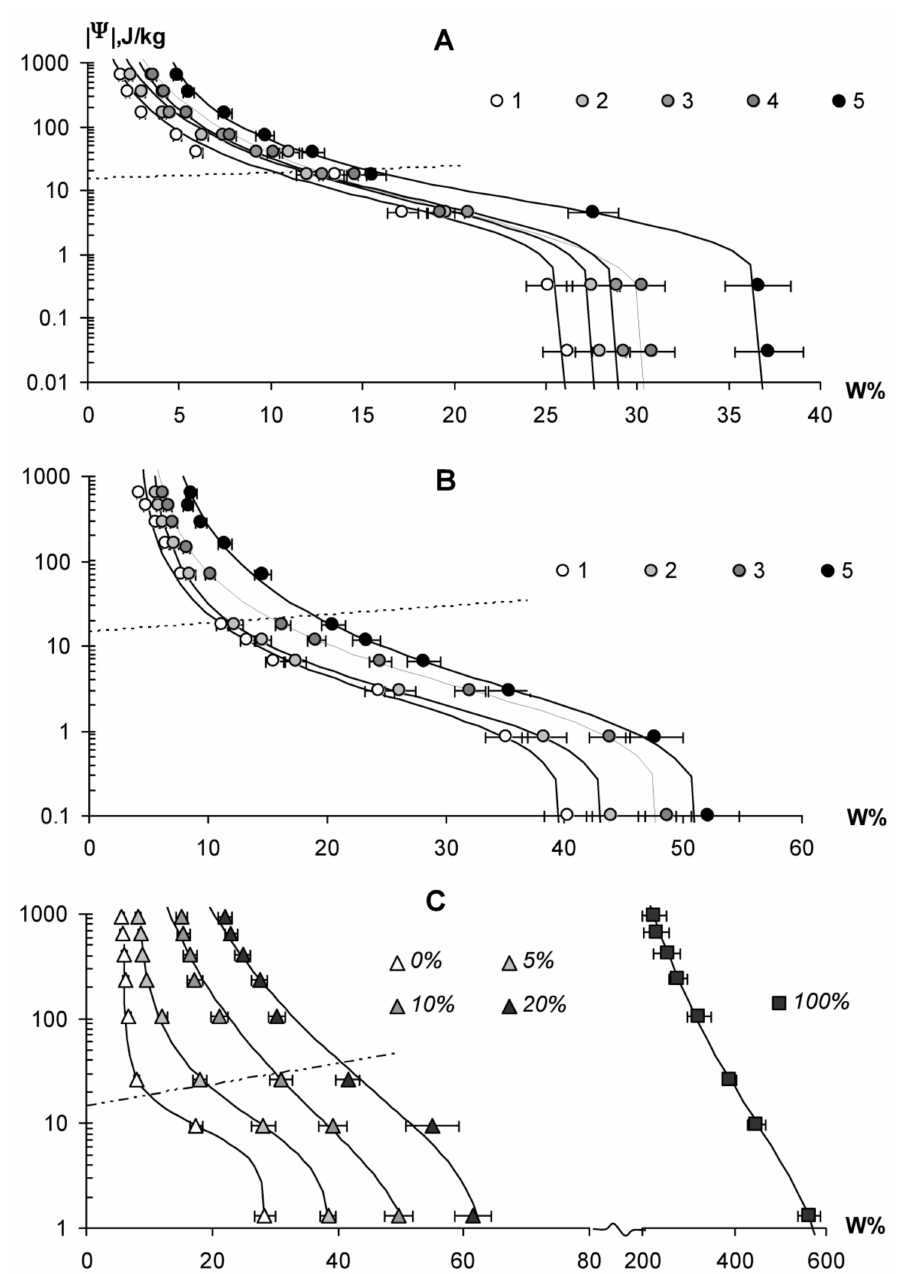
Figure 6. Dynamics of water-retaining capacity under the influence of soil conditioners and their biodegradation: ( A ) quartz sand, ( B ) silty-sand arenosol; 1–0% SSHP (control), 5–0.1% SSHP, experiment temperature: 2–37 ◦ C, 3–30 ◦ C, 4–20 ◦ C; ( C ) peat soil modifier and its mixtures with monomineralic quartz sand; %—doses of the soil-modifier in the